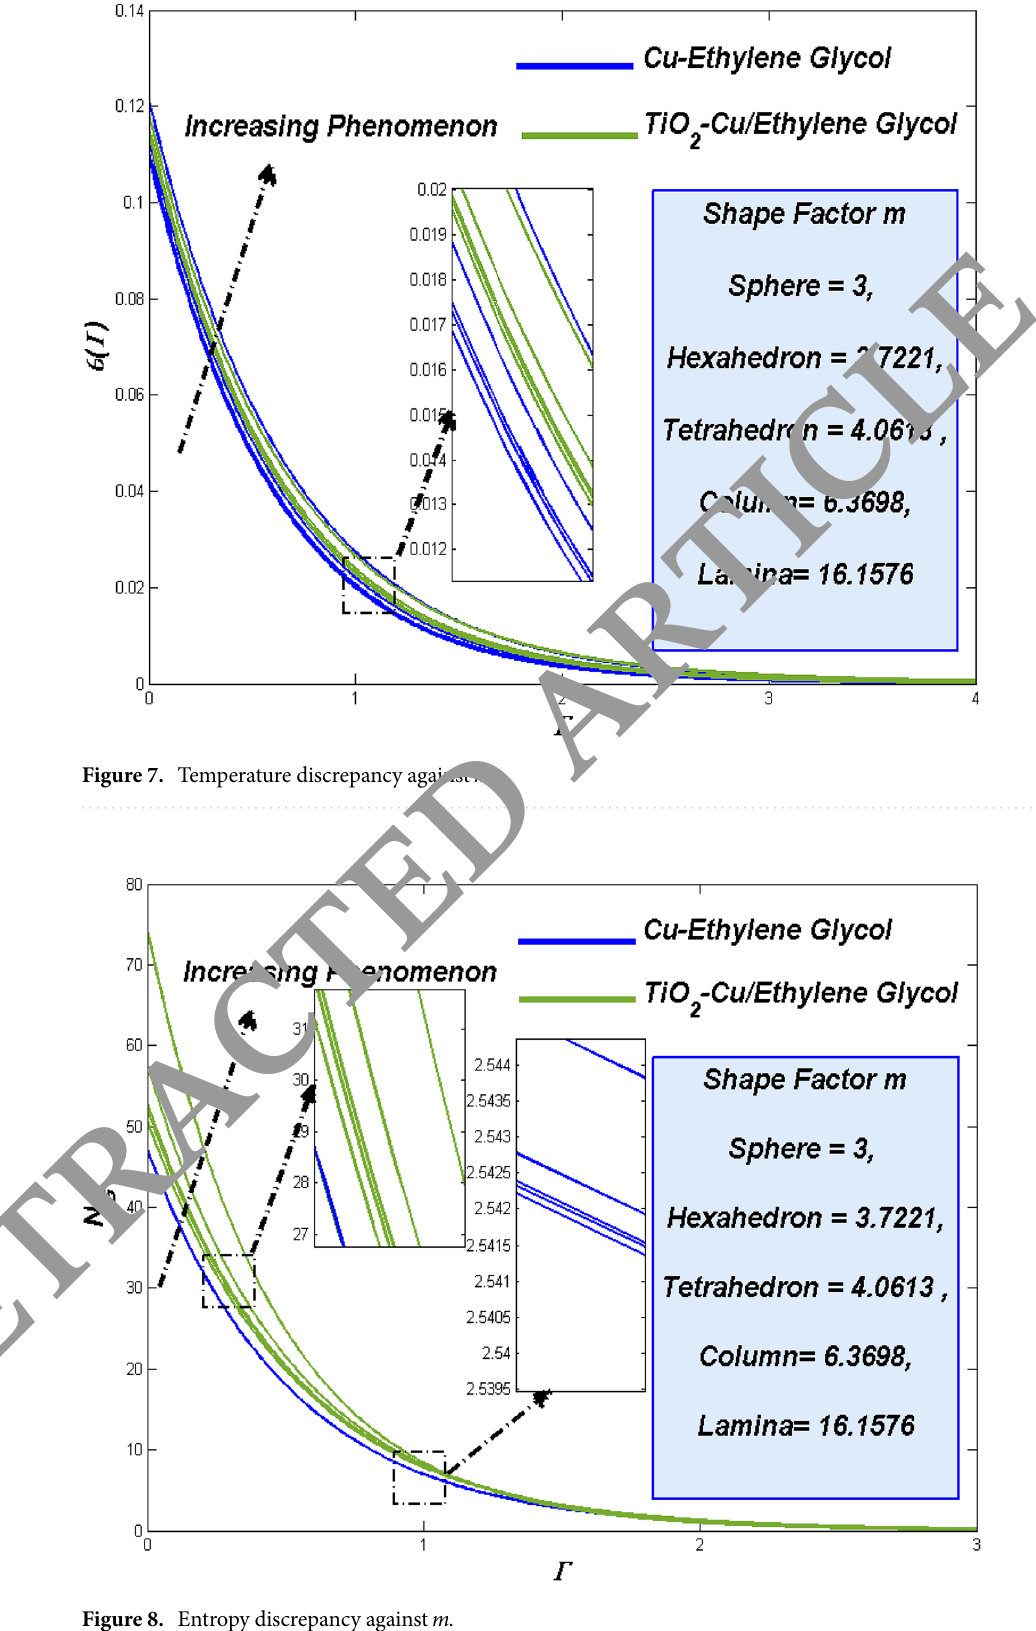
Figure 8. Entropy discrepancy against m